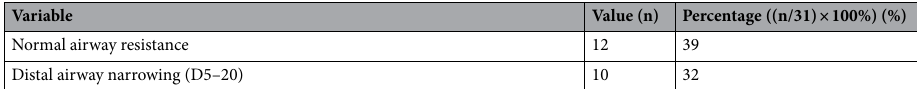
Table 1. Demographic, military location and exposure, radiologic, and pulmonary data from 31 veterans deployed to the Middle East between 2003 and 2015. † BMI categories 35 . *Some soldiers were deployed to more than one location.